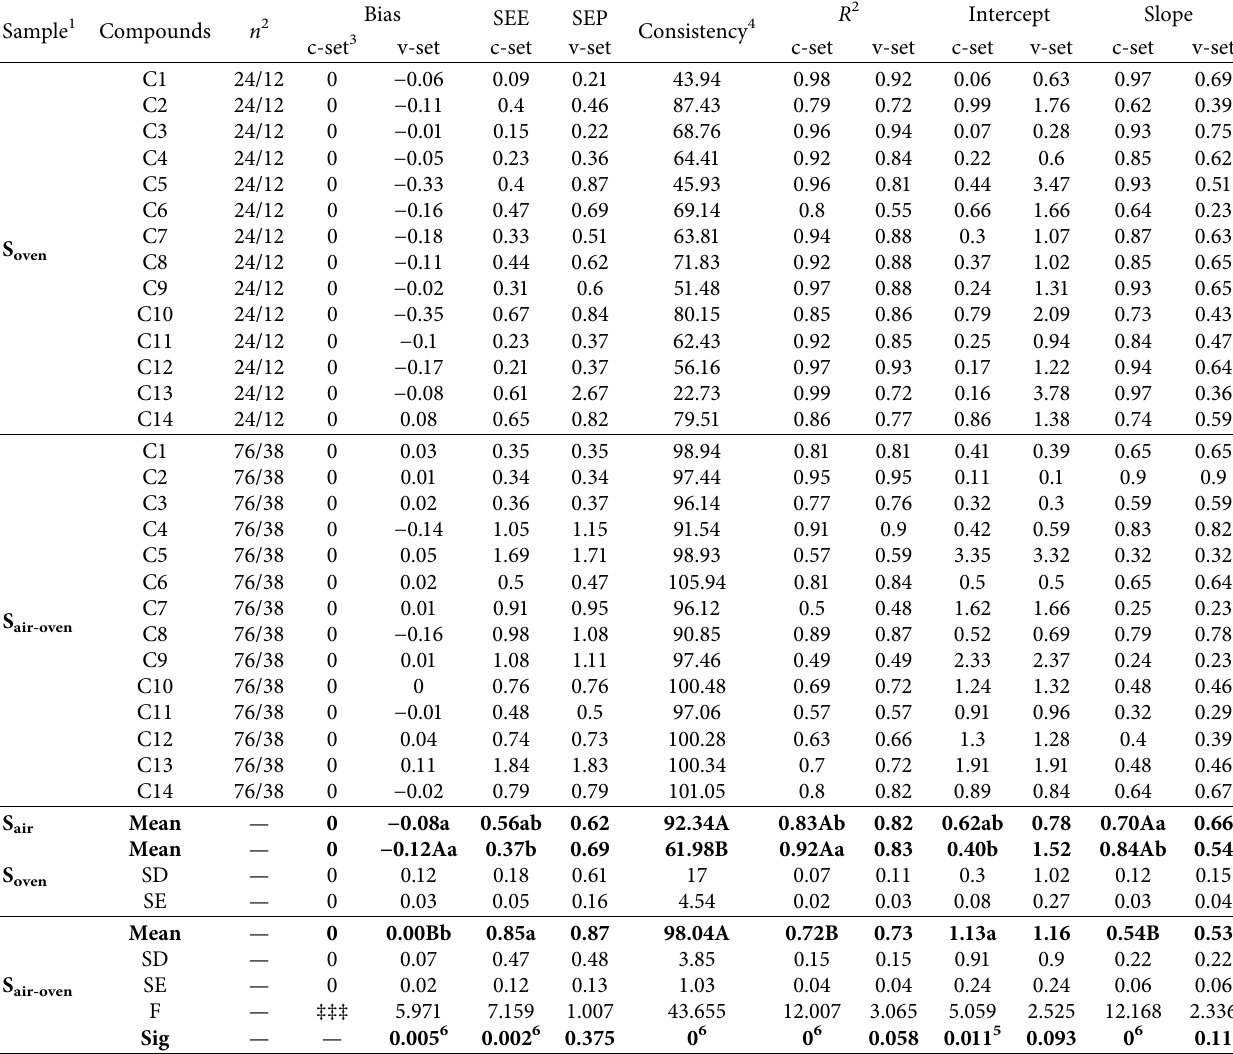
Table 4: Comparison of the regression parameters for the SCMs obtained by different sample treatments. Sample 1